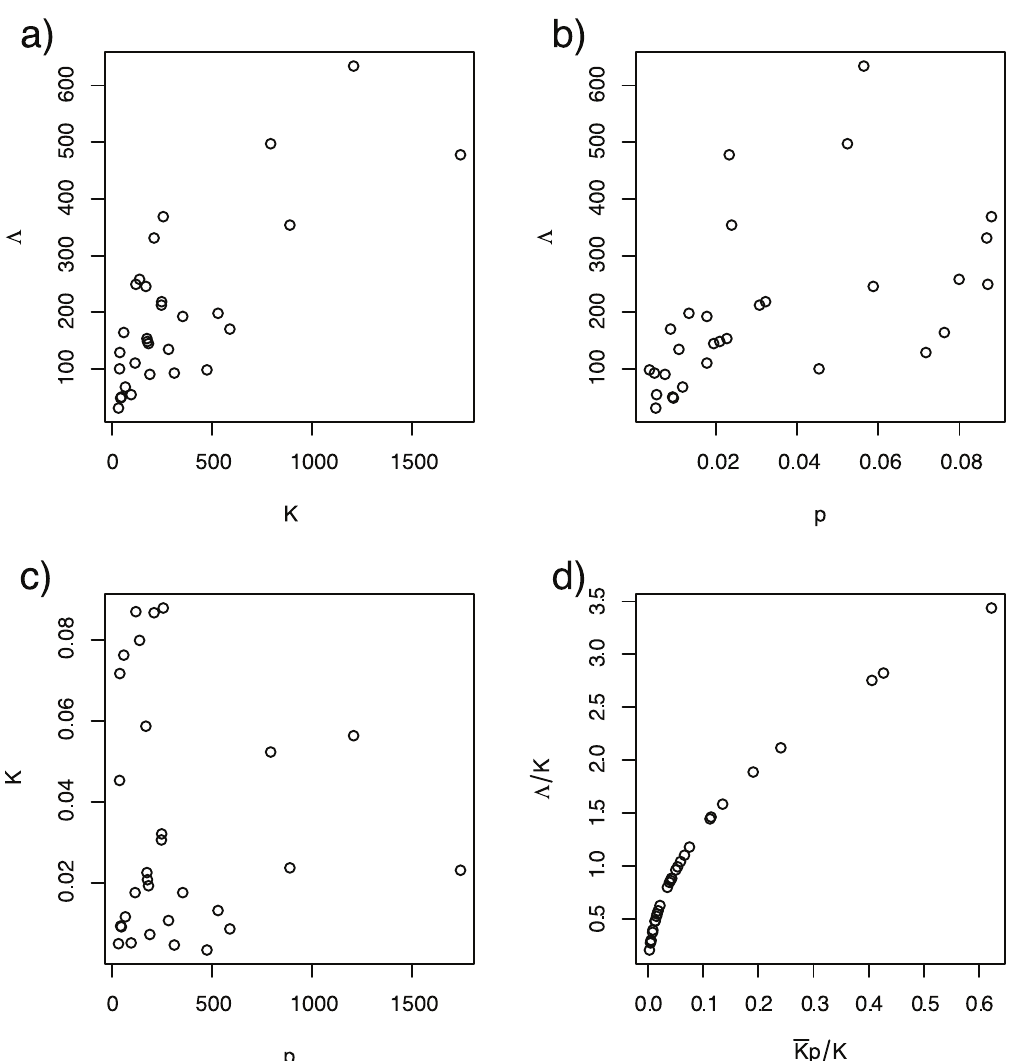
Figure 2. The scaling between egg-laying and productivity is only apparent after normalizing both productivity and egg laying by carrying capacity. In completely heterogeneous environments, there may be a poor correlation between a ) carrying capacity and productivity; b ) egg laying and productivity; and c ) egg laying and carrying capacity. d ) The crowding law governing density dependence is found by plotting the ratio of eggs laid to carrying capacity against the ratio of productivity to carrying capacity (i.e. L i = K i , p i = K i f g ). The constant (cid:2) KK ~ P scale the x